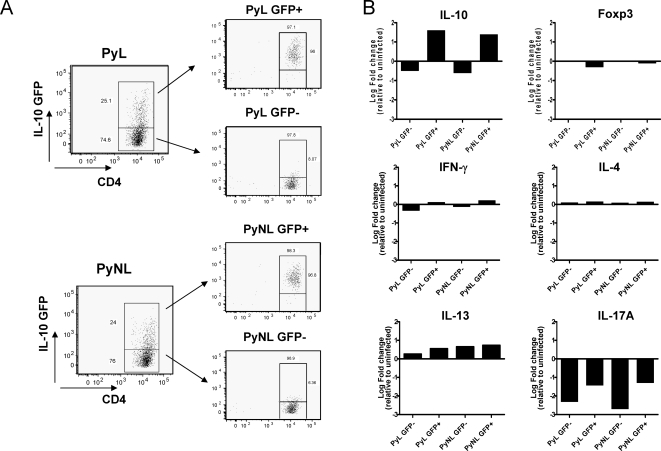
IL-10 producing CD4+ T cells that develop during P. yoelii infection are Tr1 cells and not Th1, Th2, or Th17 cells.Splenic CD4+ T cells were isolated from transgenic IL-10-GFP mice on day 7 of PyL or PyNL infection and were purified by flow cytometric cell sorting into GFP+ (IL-10+) and GFP− (IL-10−) populations. (A) shows the purity of the purified GFP+ and GFP− populations. (B) Expression of IL-10, Foxp3, IFN-γ, IL-4, IL-13 and IL-17A mRNA was determined by real time PCR (Taqman) relative to the house keeping gene, GAPDH. The results are shown as the fold change in expression relative to uninfected naïve CD4+ T cells. For Taqman analysis, purified cells from several mice in each group were pooled.